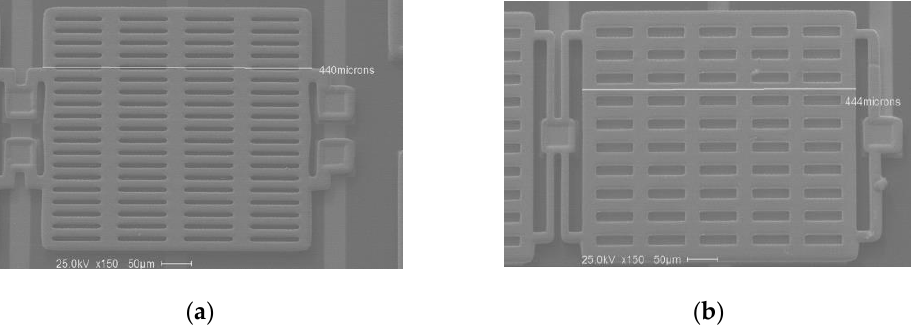
Figure 1. The step-by-step process flow for the capacitive MEMS AE sensors. The capacitive gap of 1.7 µ m is realized by a sacrificial material of either photoresist or SiO 2 . A 10 µ m-thick electroplated nickel top electrode is designed by the FEM analysis.